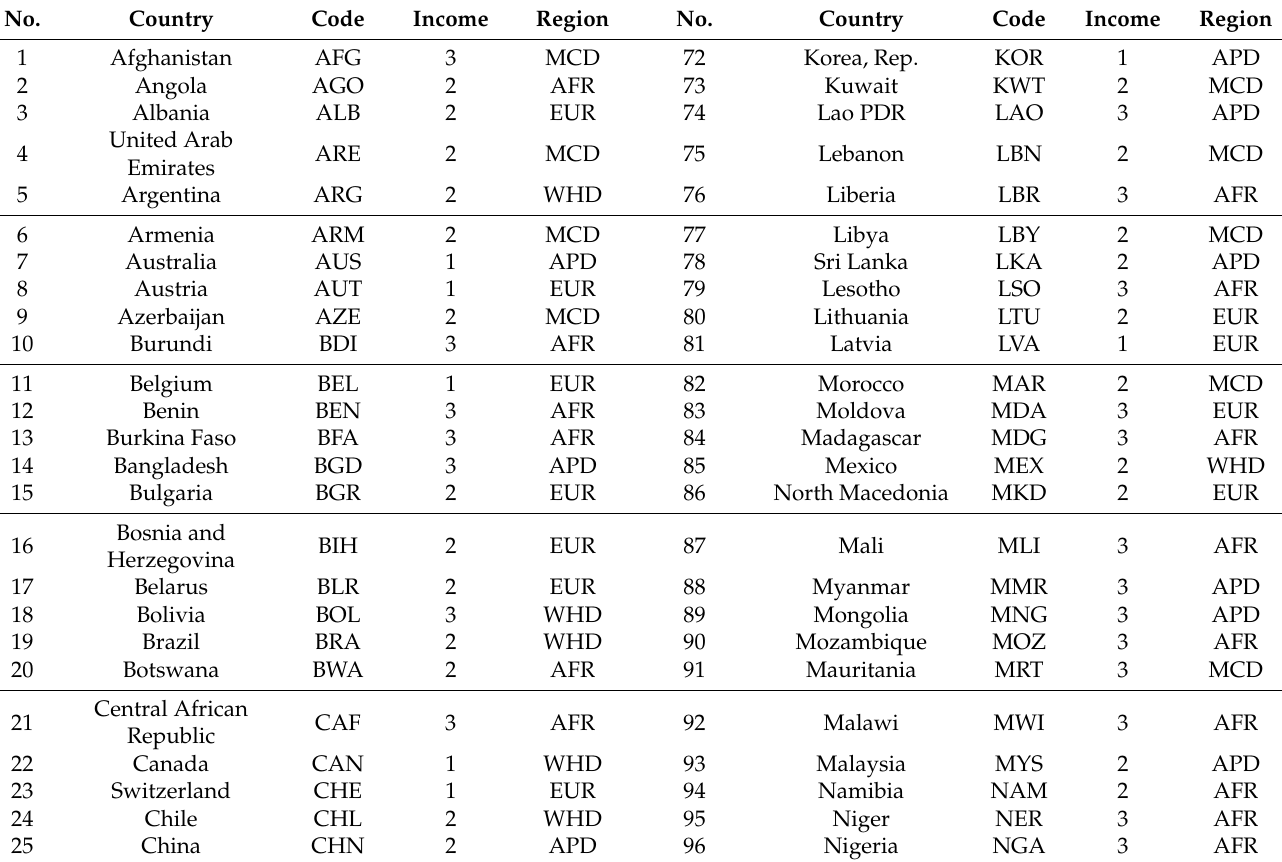
Figure A1. The correlation between WPUI and FDI. Source: Authors’ calculation. Table A1. Country list.